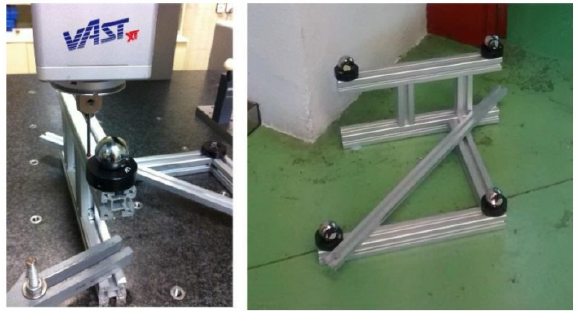
Figure 6. Reflector standard gauge.